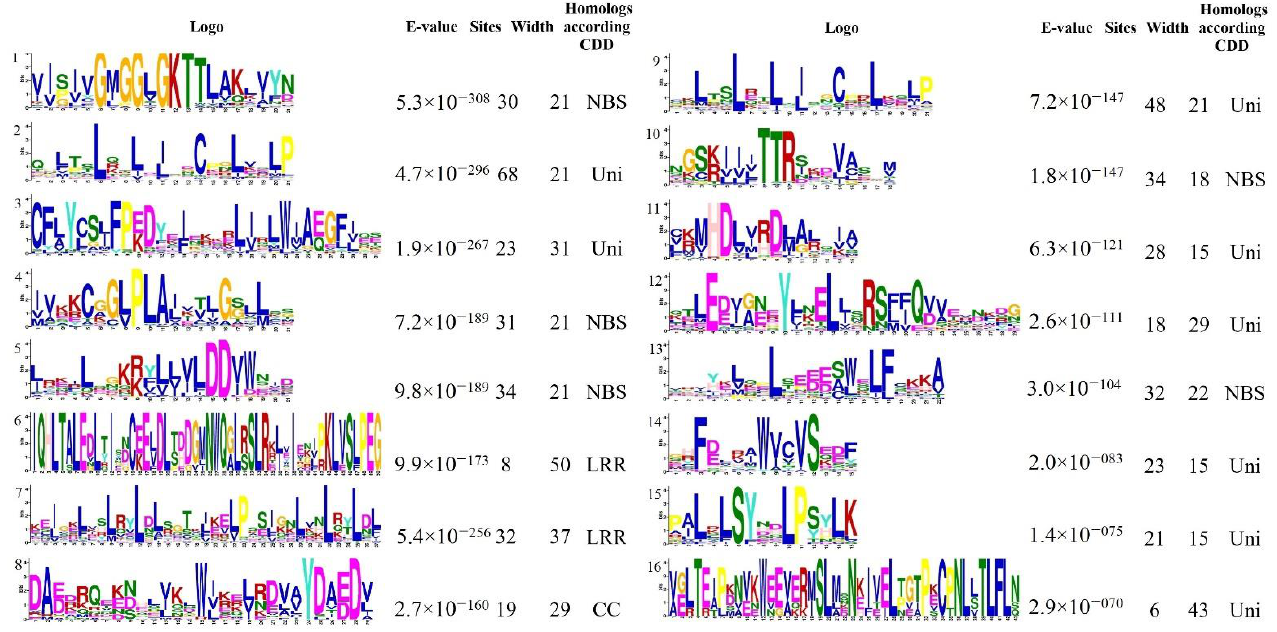
Figure 2. Sequence logos of 16 conserved motifs identified in 111 putative R genes of R. nigrum . Sequence logo representation was generated from multiple alignments with MEME software.